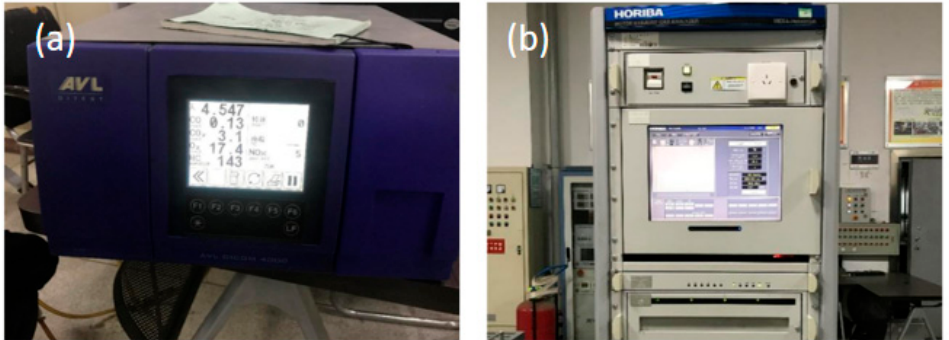
Figure 2. Engine bench test device diagram. ( a ) Engine’s testing bench. ( b ) The CA4D28C5 diesel engine testing device.